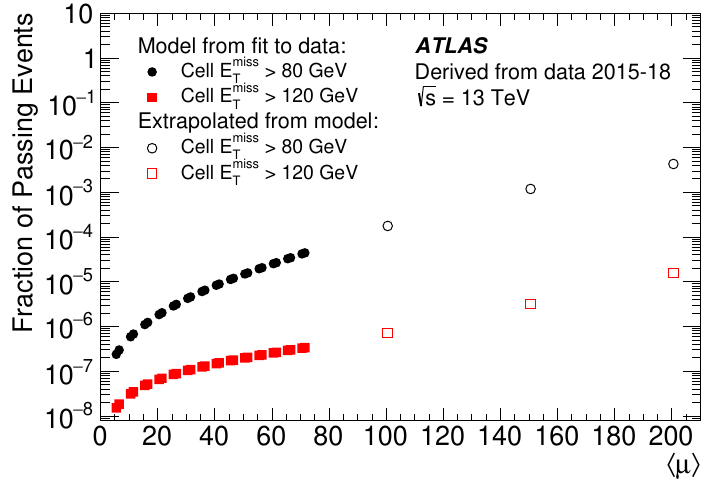
Figure 2. The E miss model predicted trigger rate as a function of (cid:22) for the cell E miss T with a threshold of 80 GeV and 120 GeV, assuming no additional pile-up mitigation.